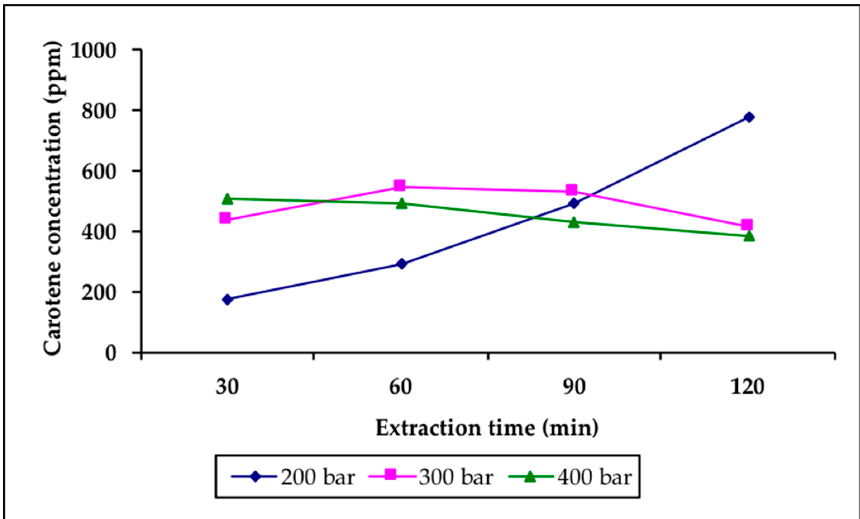
Figure 5. Carotenoids as extracted with SCCO 2 at 45 °C and 14 kg h − 1 kg − 1 .